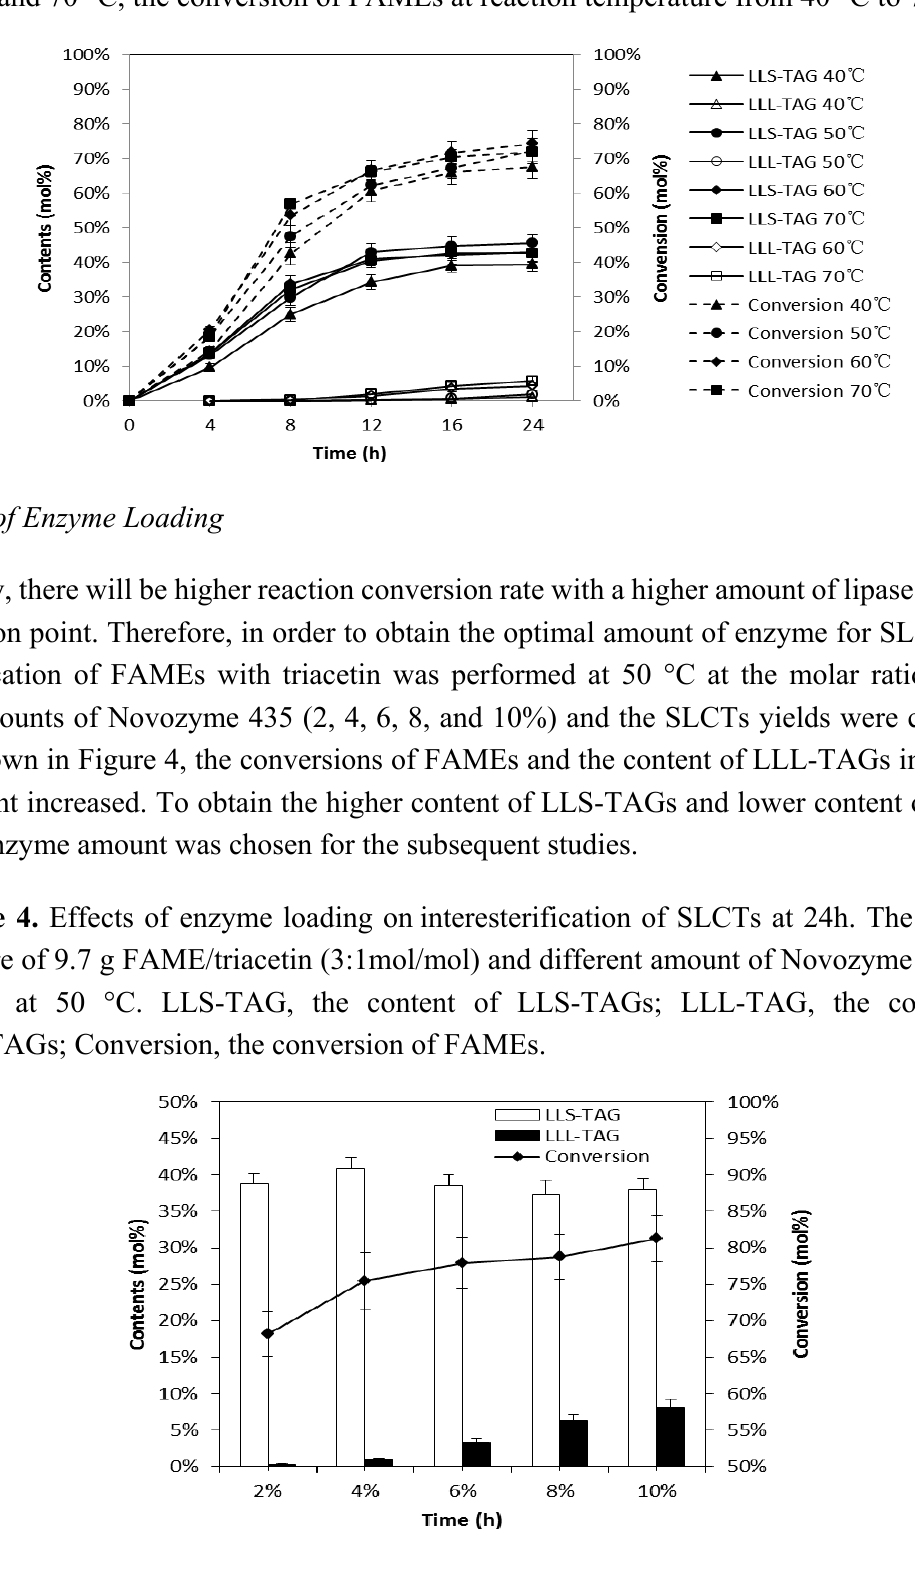
Figure 3. Effects of reaction temperature on interesterification of SLCTs at different time points. The reaction mixture was 9.7g FAME/triacetin (3:1 mol/mol) and 2% (w/w) Novozyme 435. LLS-TAG 40 °C, 50 °C, 60 °C and 70 °C, the content of LLS-TAGs at reaction temperature from 40 °C to 70 °C, respectively; LLL-TAG 40 °C, 50 °C, 60 °C and 70 °C, the content of LLL-TAGs at reaction temperature from 40 °C to 70 °C; Conversion 40 °C, 50 °C, 60 °C and 70 °C, the conversion of FAMEs at reaction temperature from 40 °C to 70 °C.